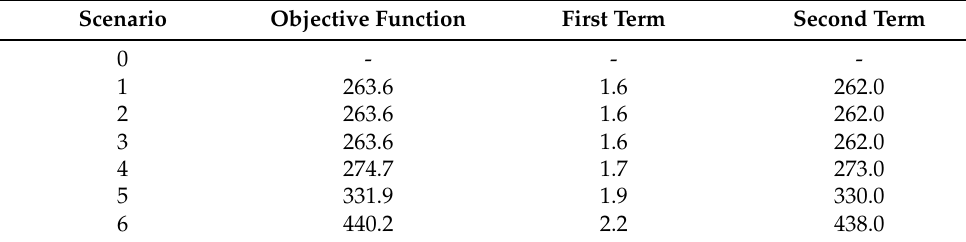
Table 5. Objective function and its breakdown for each